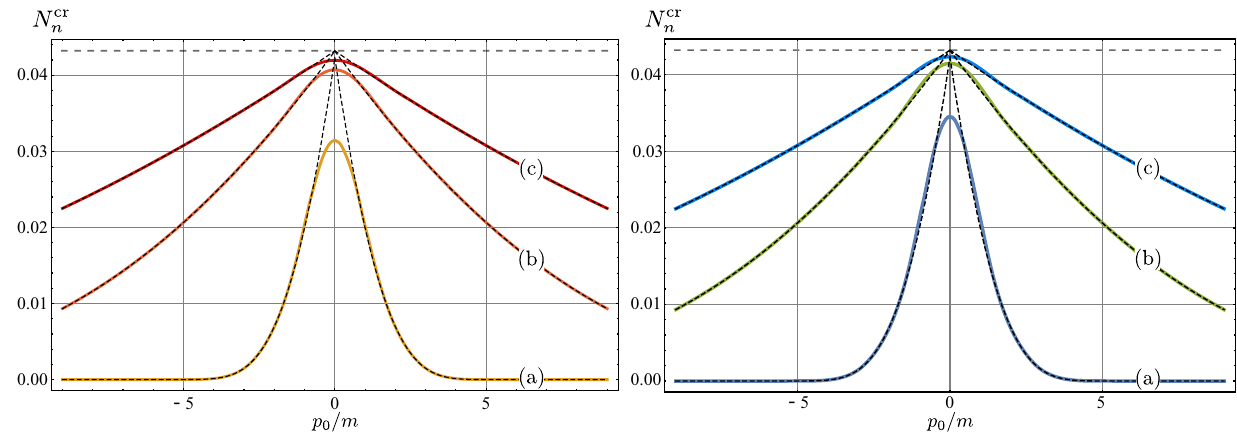
approximations (65). In a–c, m ξ 1 = m ξ 2 = 10, 50 and 100, respec- tively, and E = E c in all cases. The horizontal dashed lines denote the uniform distribution e − πλ